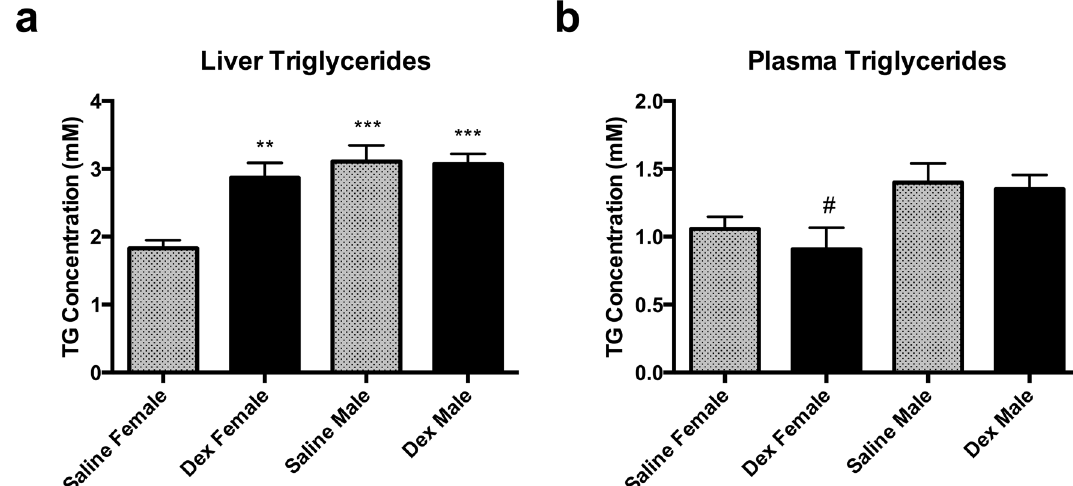
Figure 1. Triglyceride concentrations in the liver and plasma of saline and Dex exposed offspring. Levels of triglycerides were measured in the liver ( a ) and plasma ( b ) by the Triglyceride Quantification Assay (Abcam) in a colorimetric assay at 570 nm. For the livers, the triglyceride concentration was normalized to the weight of the tissue used for the analysis. The plasma samples were assay directly. The triglyceride concentrations in mM are represented graphically. Statistical significance between saline and Dex groups and sex was determined by one-way ANOVA with a post-hoc Tukey test. Data are presented as mean ± SEM (n = 8). Statistical significance between groups is shown by: * p < 0.05, ** p < 0.01, *** p < 0.001. The * indicates significance when compared to saline female group and the # indicates significance when compared to the saline male